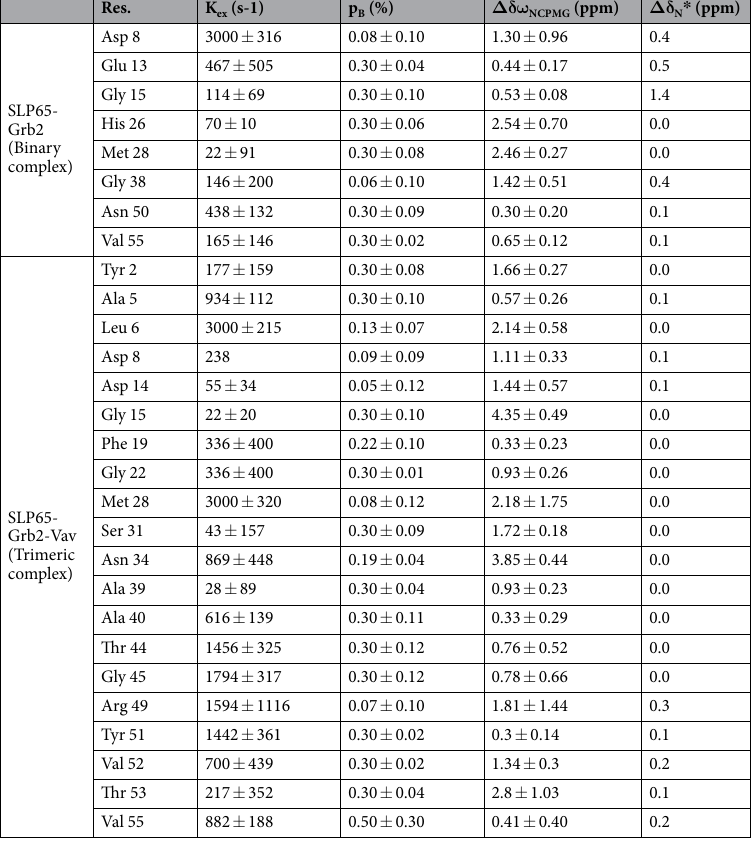
Table 2. Physical parameters obtained by fitting the 15 N relaxation dispersion profiles of individual residues of Grb2 in the SLP65-Grb2 binary complex as well as the SLP65-Grb2-Vav trimeric complex to a two-site exchange process using eq. 2. * Changes in the Δδ N of Grb2 SH3C in the complex with Vav SH3N in a 1 H 15 N HSQC